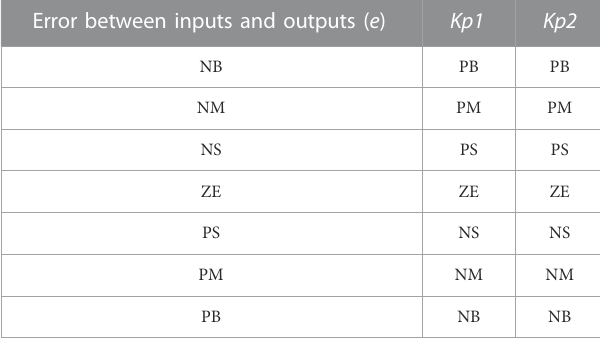
TABLE 1 Fuzzy rule table. Error between inputs and outputs ( e